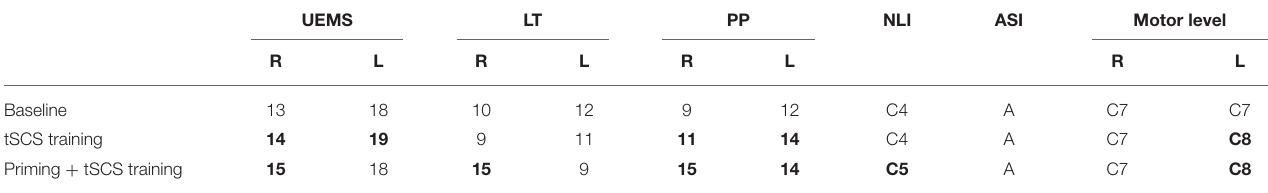
TABLE 1 | ISNCSCI scores during baseline, after 5 weeks of “tSCS training”, and after 5 weeks of “priming & tSCS training”. UEMS LT PP